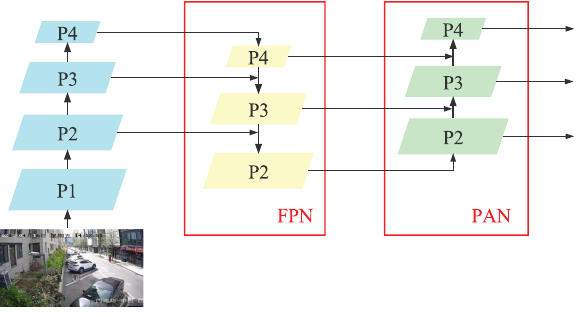
Figure 5. The FPN+PAN